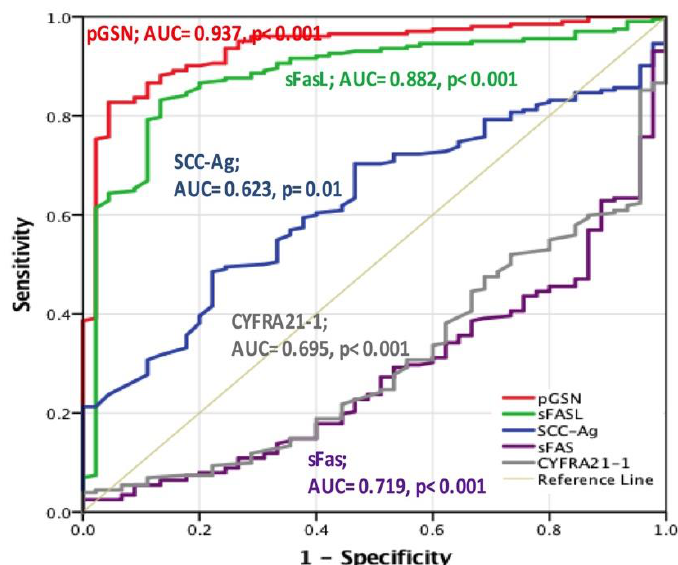
Figure 2. Receiver operating characteristic curves for all candidate circulating cancer biomarkers revealed pGSN to be the optimal predictor of HNC. The area under curve (AUC) of circulating pGSN was 0.937 ( p < 0.001), whereas it was 0.882 for sFasL ( p < 0.01), 0.695 for CYFRA21-1 ( p < 0.001), 0.623 for SCC-Ag ( p < 0.001), and 0.719 for sFas ( p < 0.001).